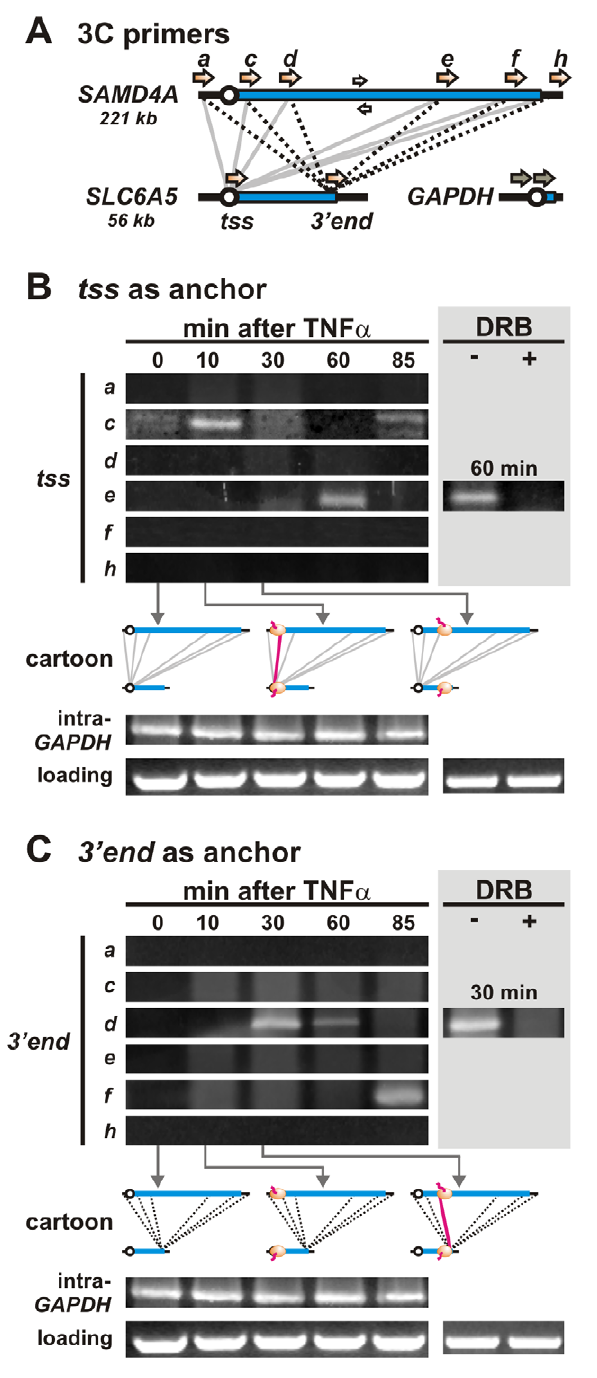
Figure 4. Contacts between two TNF a -responding genes on different chromosomes (14 and 11) follow engaged polymer- ases. (A) Positions of 3C primers and the interactions screened (grey and dotted black lines). (B) Contacts between the tss of SLC6A5 (the anchor) and different parts of SAMD4A . Contacts/bands are only detected when polymerases are on both contacting partners. (C) Contacts between the 3 9 end of SLC6A5 (the anchor) and different parts of SAMD4A . As in (B), two strong bands are seen, but they are in different positions. We suggest this is because it takes a polymerase 20–30 min to reach the 3 9 end of SLC6A5 now used as an anchor; then, contacts/bands are again only detected when polymerases are on both contacting partners. Panels (B) and (C) share the same pair of loading and intra- GAPDH controls (excluding 6 DRB), so the same image is shown in both panels.